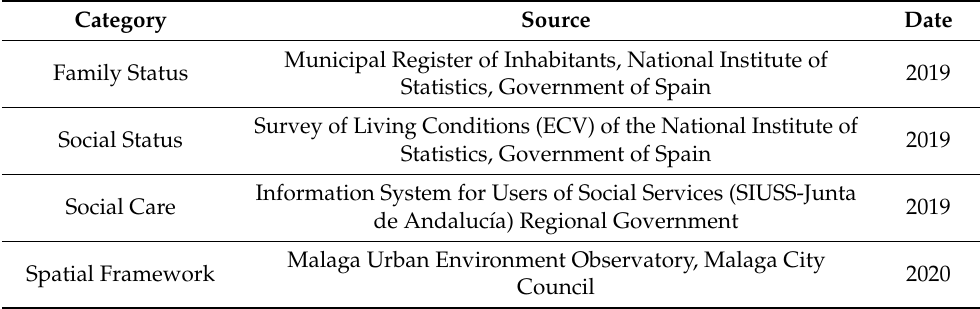
Table 2. Summary of the categories of the model and the data sources for each. Source: Authors. Category